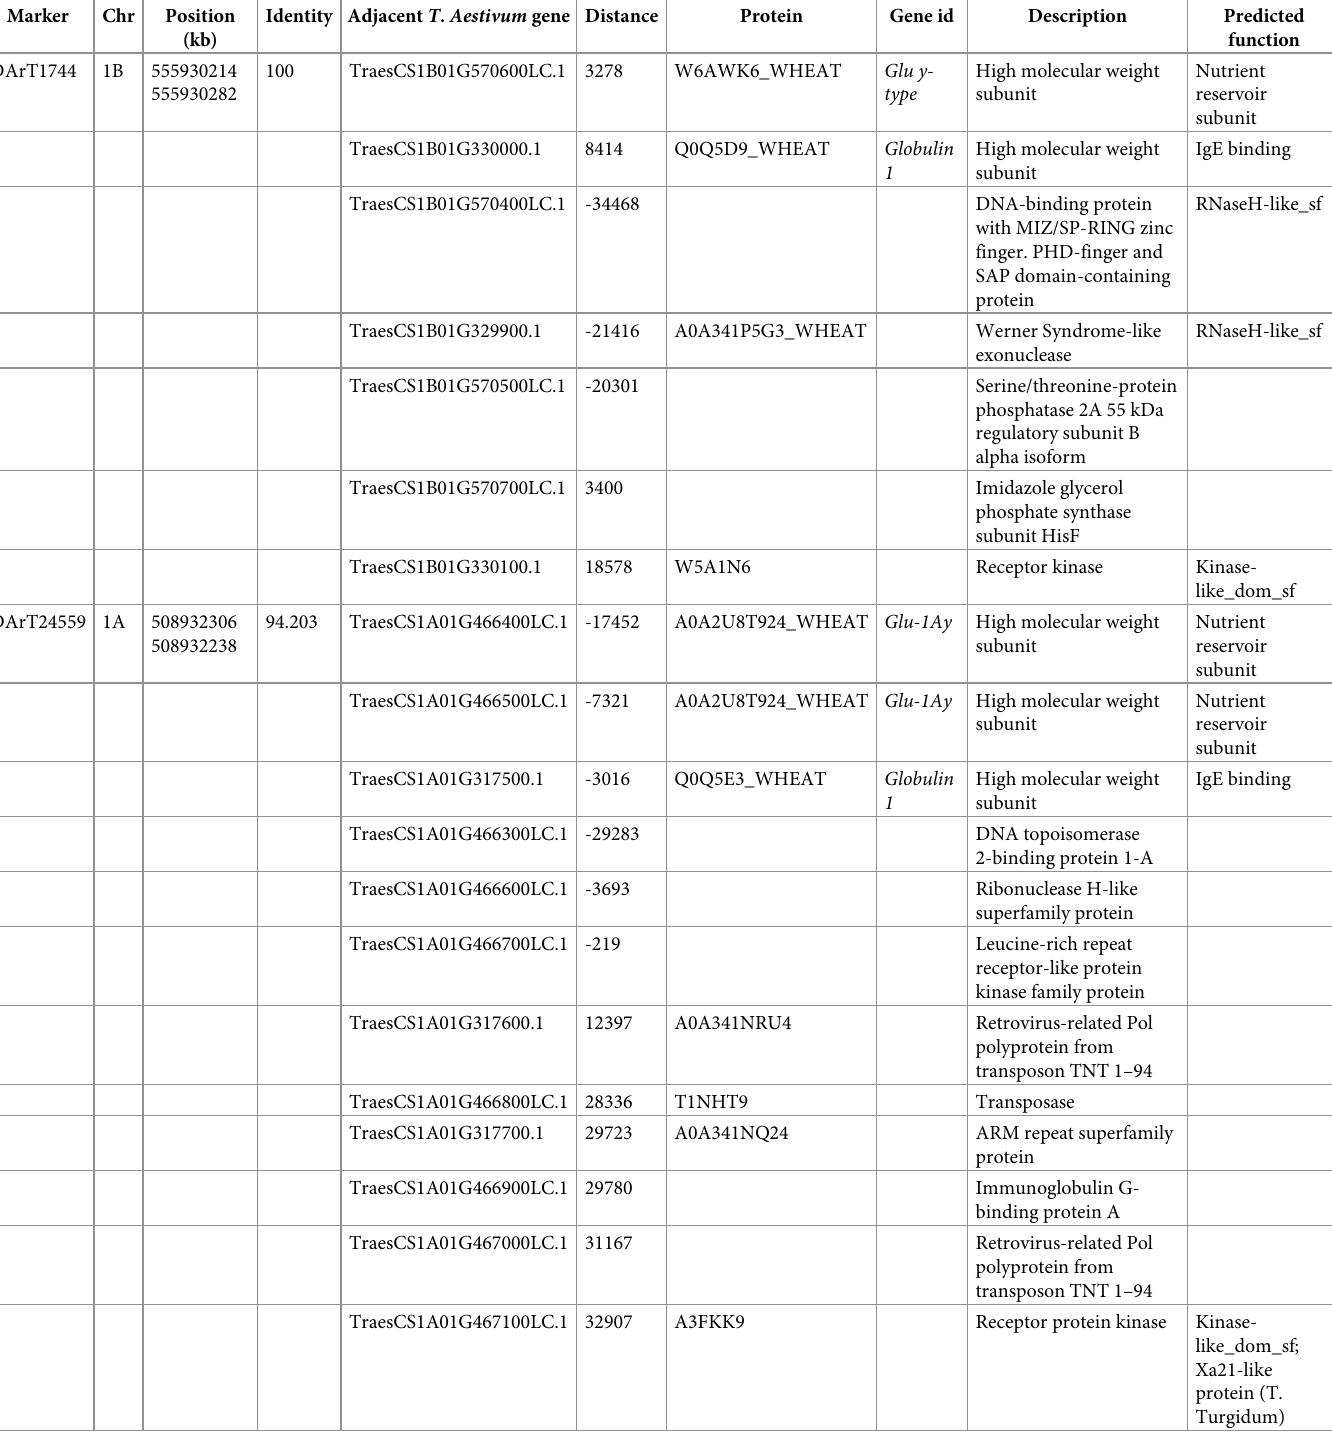
Table 4. Genes located in the proximity of markers DArT1744 and DArT24559 (within a +-50kb